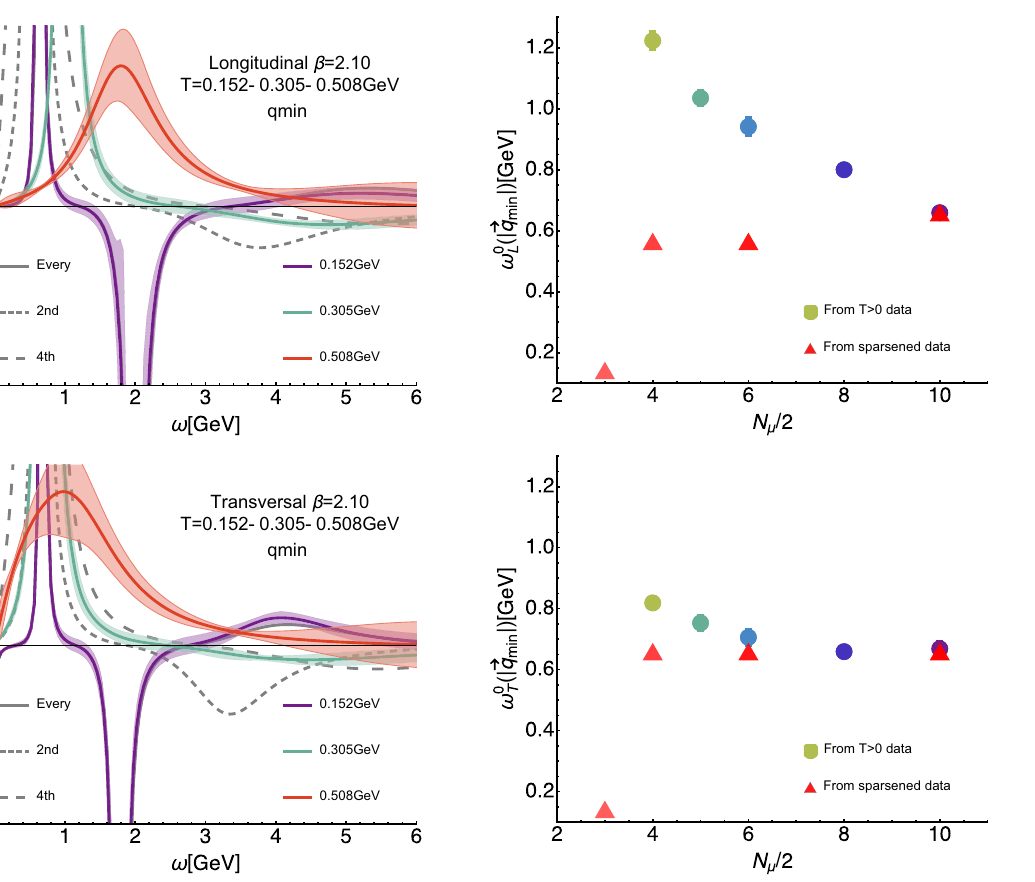
trough has weakened more strongly than what a degradation in recon- struction resolution (gray small dashed line) alone results in. (Right) Comparison of the actual finite-temperature values of the dominant ( | q | ) (circles) to the peak position reconstructed peak position ω 0 min L / T from the sparsened low-temperature correlator (red triangles). We see that the systematic error from the truncation pushes the values to lower values, while the tendency observed in the actual T > 0 data is in the opposite